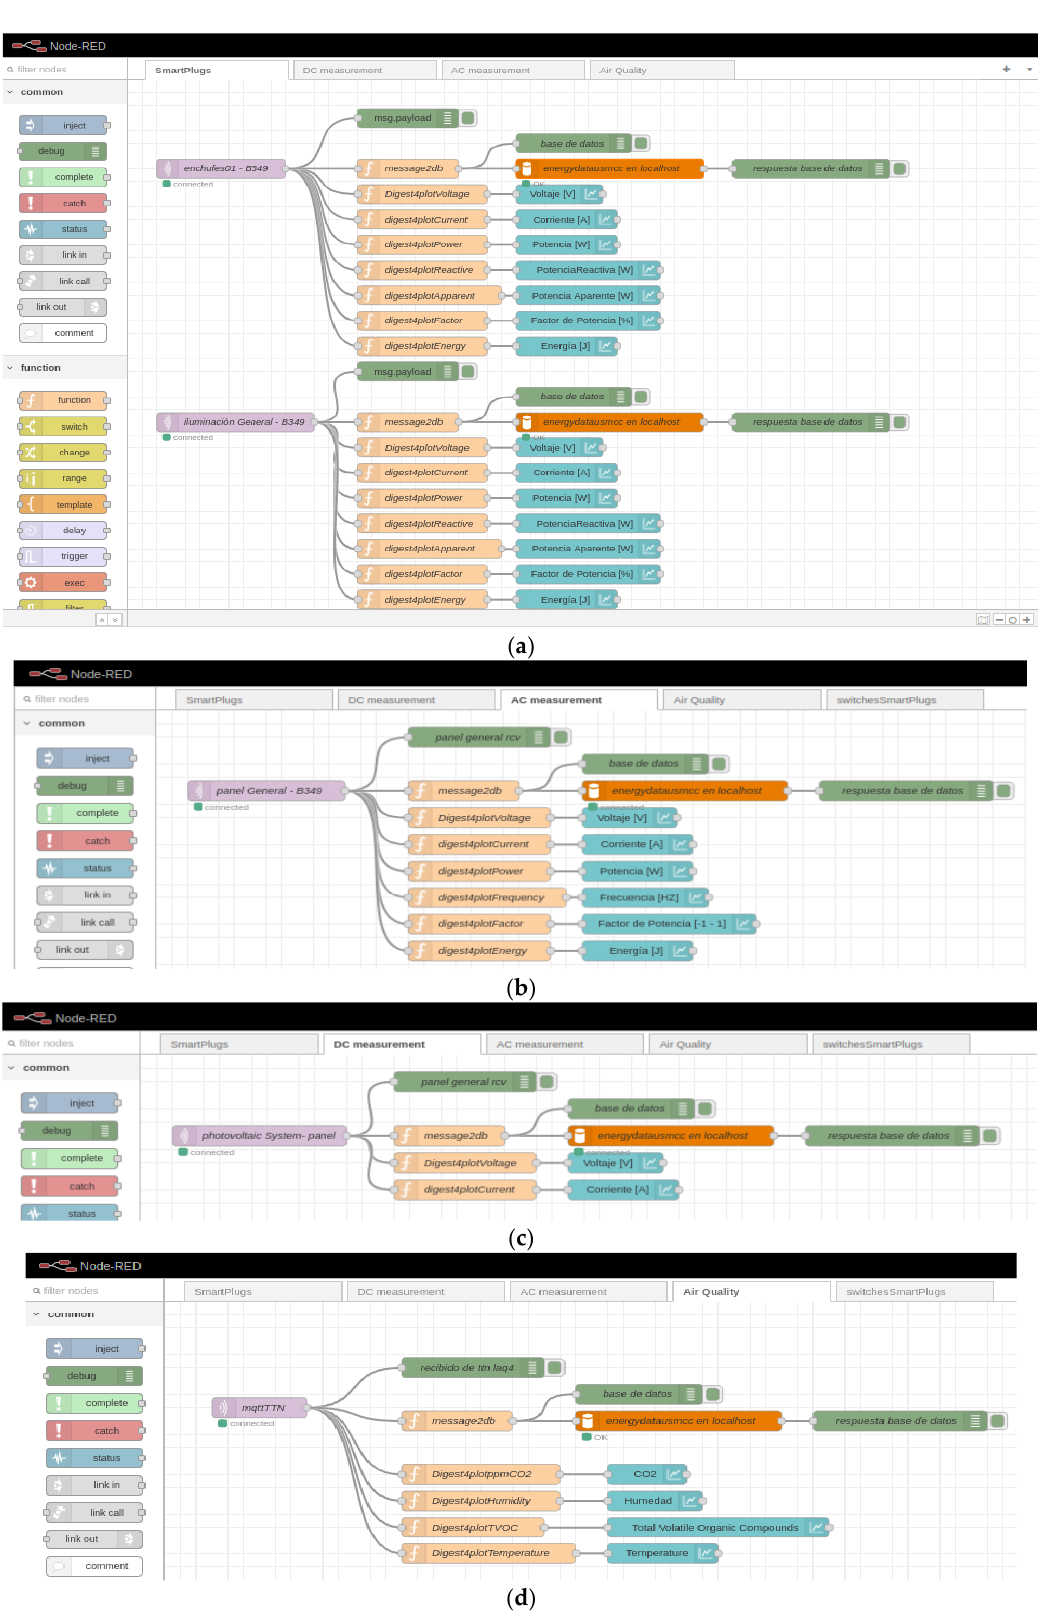
Figure 9. Configuration for Node-RED for data visualization: ( a ) Smart plugs; ( b ) Electric panel; ( c ) PV system; and ( d ) Air quality.